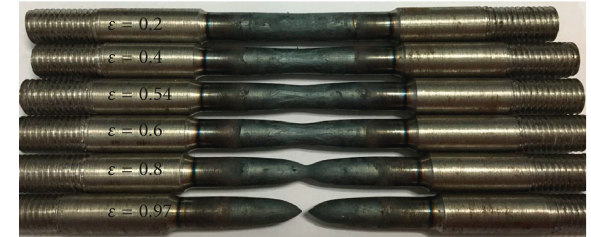
Figure 7: Samples after hot deformation: ε ε 0 . 6, ε 0 . 8, and ε (cid:31) (cid:31)